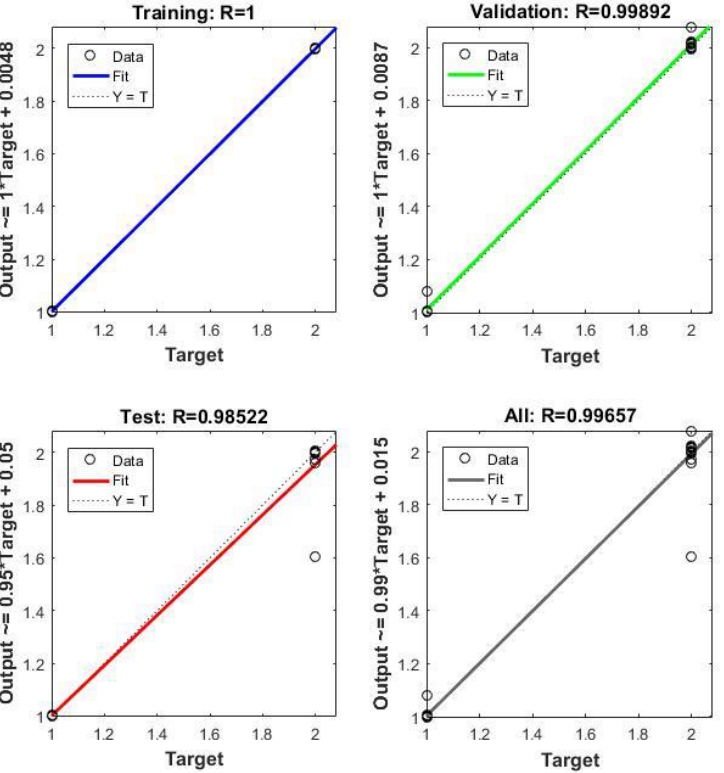
Figure 4. The regression lines of the optimum classifier model. 1 and 2 refer to groups 1 and 2, respectively.